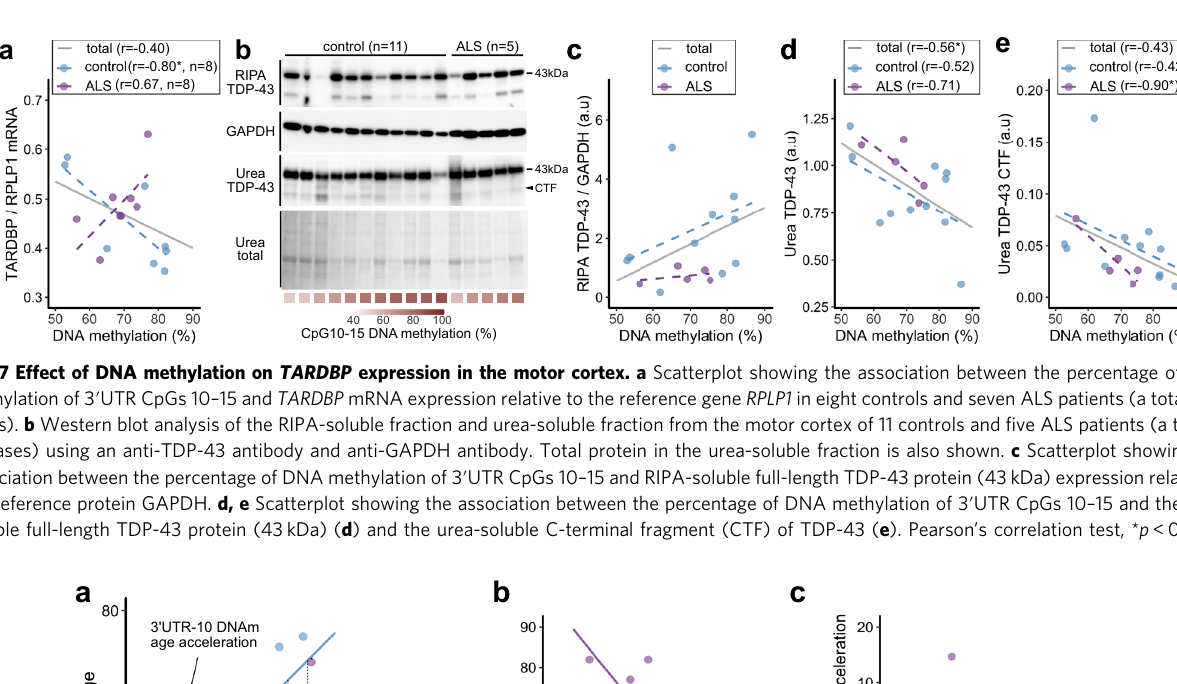
incorporating dCas9-peptide repeats and the catalytic domain of the DNA demethylase (scFv-TET1) was applied to demethylate the target DNA region (Fig. 2b) 34 . A DNMT3A- TARDBP -target vector incorporating dCas9 and DNMT3A, which is the catalytic domain of the DNA methyltransferase, was applied for methylation of the target DNA region (Fig. 2b) 35 .